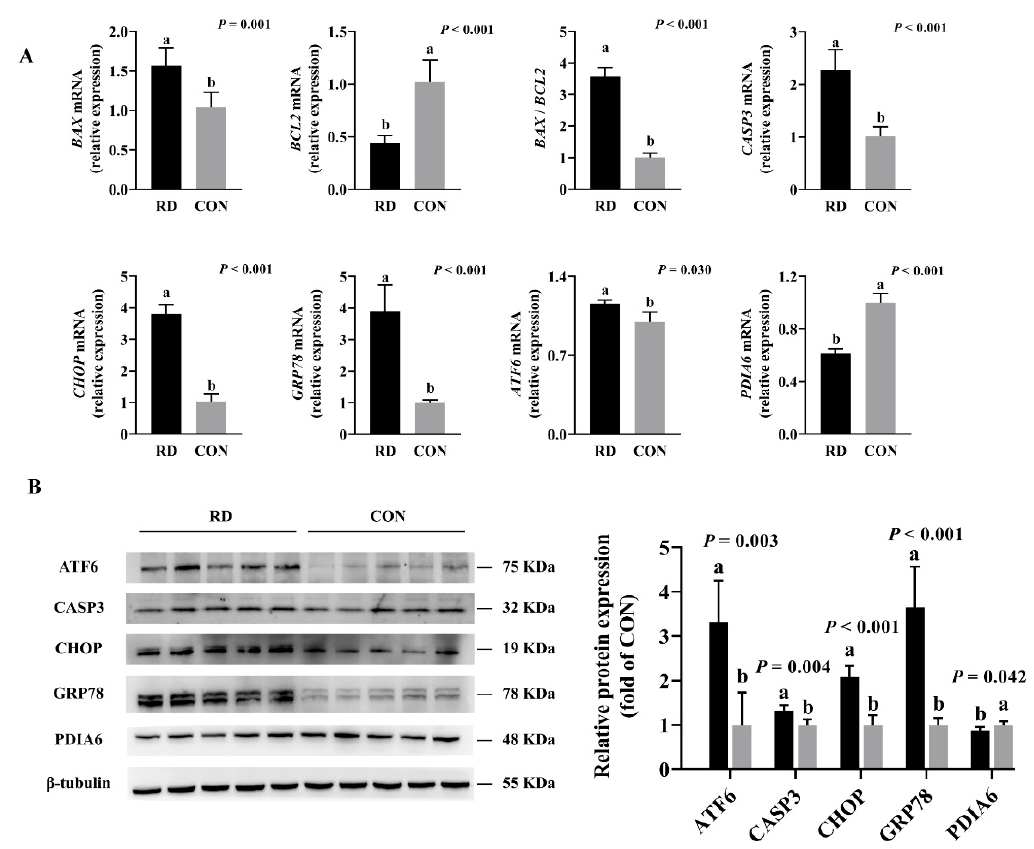
Figure 5. Real-time PCR and Western blot analyses verify gene and protein expressions of HepG2 cells. ( A ) Results of RD on the mRNA expression of ER stress and apoptosis. Representative real-time PCR of BAX , BCL2 , BAX / BCL2 , CASP3 , CHOP , GRP78 , ATF6 , and PDIA6 are displayed. Each